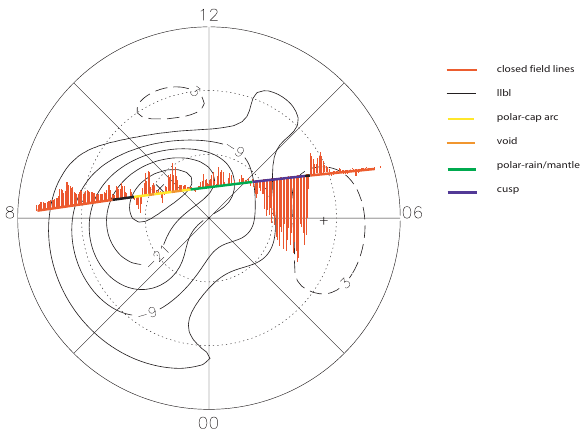
Fig. 8. The map-potential flow contours for the interval 13:34 to 13:36 UT, overlaid is the track of the F13 spacecraft from 13:24 to 13:41 UT. The track is colour coded to show the different plasma regions. Overlaid are the cross-track plasma velocity vectors mea- sured by the DMSP